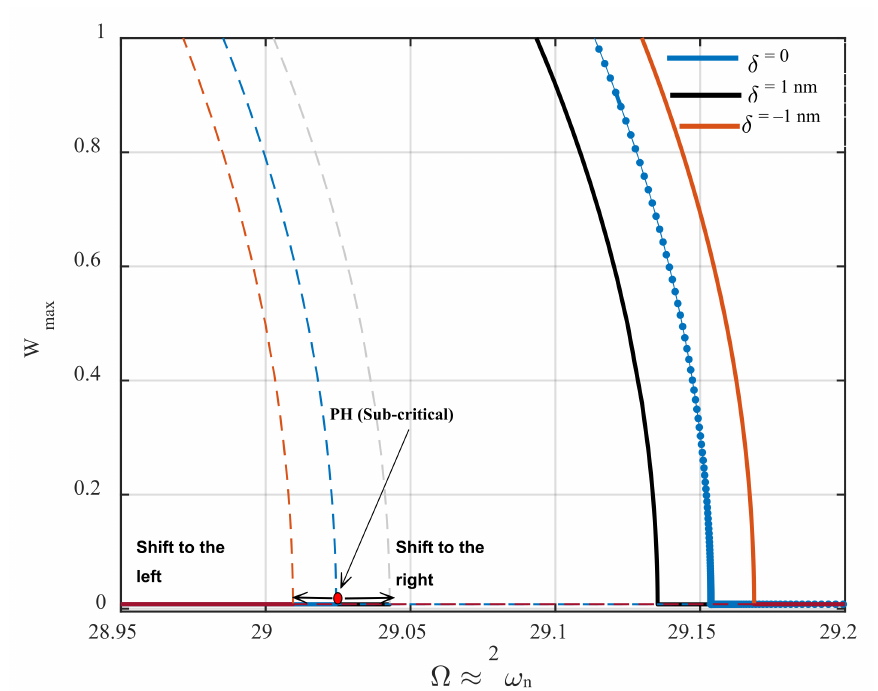
Figure 6. The influence of the surface profile variations on the primary Hopf bifurcation points near parametric resonance for the base excitation amplitude of 0.23 nm. The dashed and solid lines are unstable and stable branches,